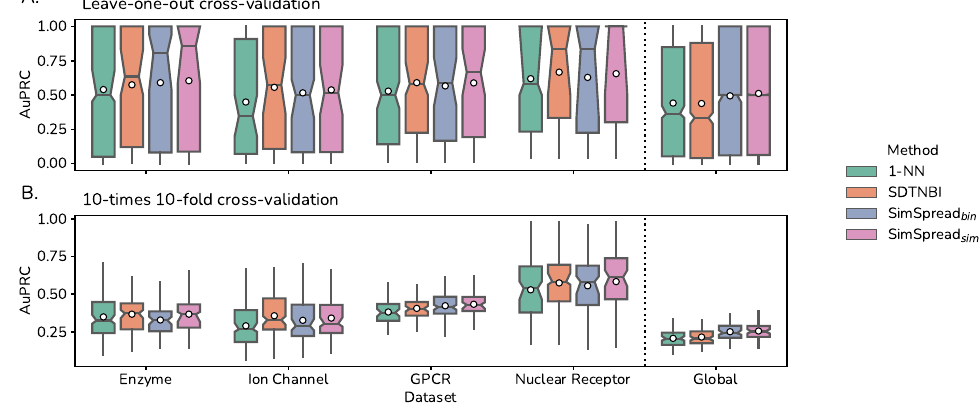
Figure 3. Predictive performance comparison with other methods in LOO and 10-fold cross- validation. Boxplots for AuPRC obtained from ( A ) leave-one-out and ( B ) 10-times 10-fold cross- validation over five datasets for 1-NN, SDTNBI, SimSpread bin and SimSpread sim using the ECFP4 molecular descriptor and Tanimoto coefficient as similarity measure. For SimSpread variants, the sim- ilarity cutoff corresponds to the one that maximizes mean AuPRC per dataset. Boxplot notch rep- resents the bootstrapped 95% confidence interval (CI) around the median, the white dot represents the mean and whiskers correspond to 1.5 × interquartile range (IQR). Charts for other performance metrics are available from the Figures S3 and